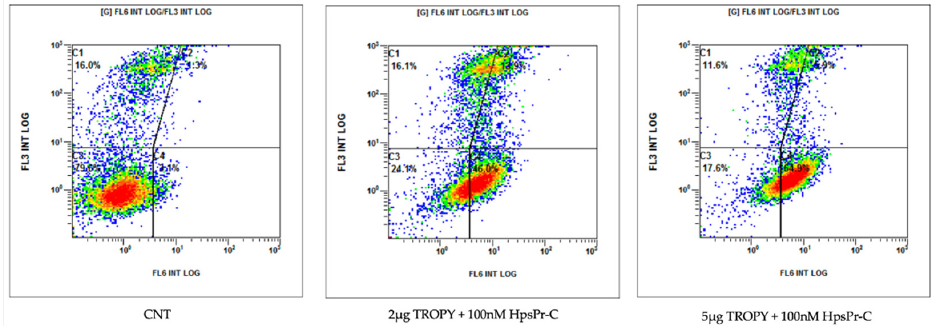
Figure 7. Apoptosis levels in PC-3 cells transfected with HpsPr-C using TROPY. Figures show the population of apoptotic cells upon transfection of 100 nM of PPRH with increasing amounts of TROPY (2 µg/mL and 5 µg/mL). The displacement of the population of apoptotic cells is shown in the right lower quadrant. Images are representative of three experiments.